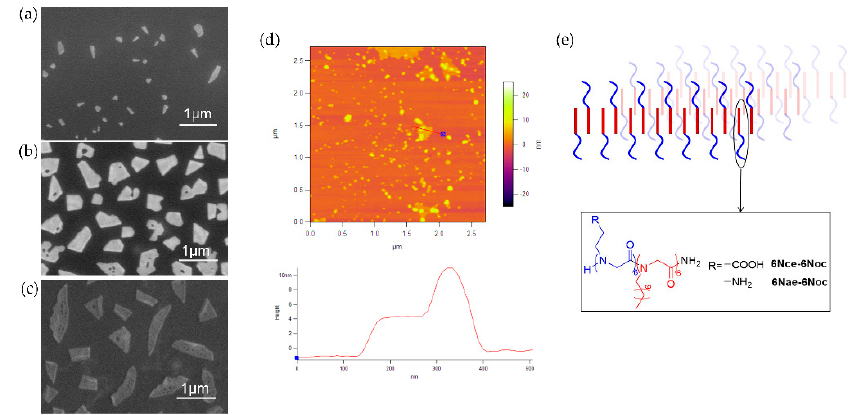
Figure 3. SEM images of self-assembled membrane-like nanomaterials from ( a ) 6Nce-6Noc, ( b ) 6Nae-6Noc and ( c ) the mixture of 6Nce-6Noc/6Nae-6Noc (1/1); ( d ) AFM image of self-assembled membrane-like nanomaterials from 6Nae-6Noc and the cursor profile for the line in the image; ( e ) illustration of bilayer formed from peptoid diblock copolymers.